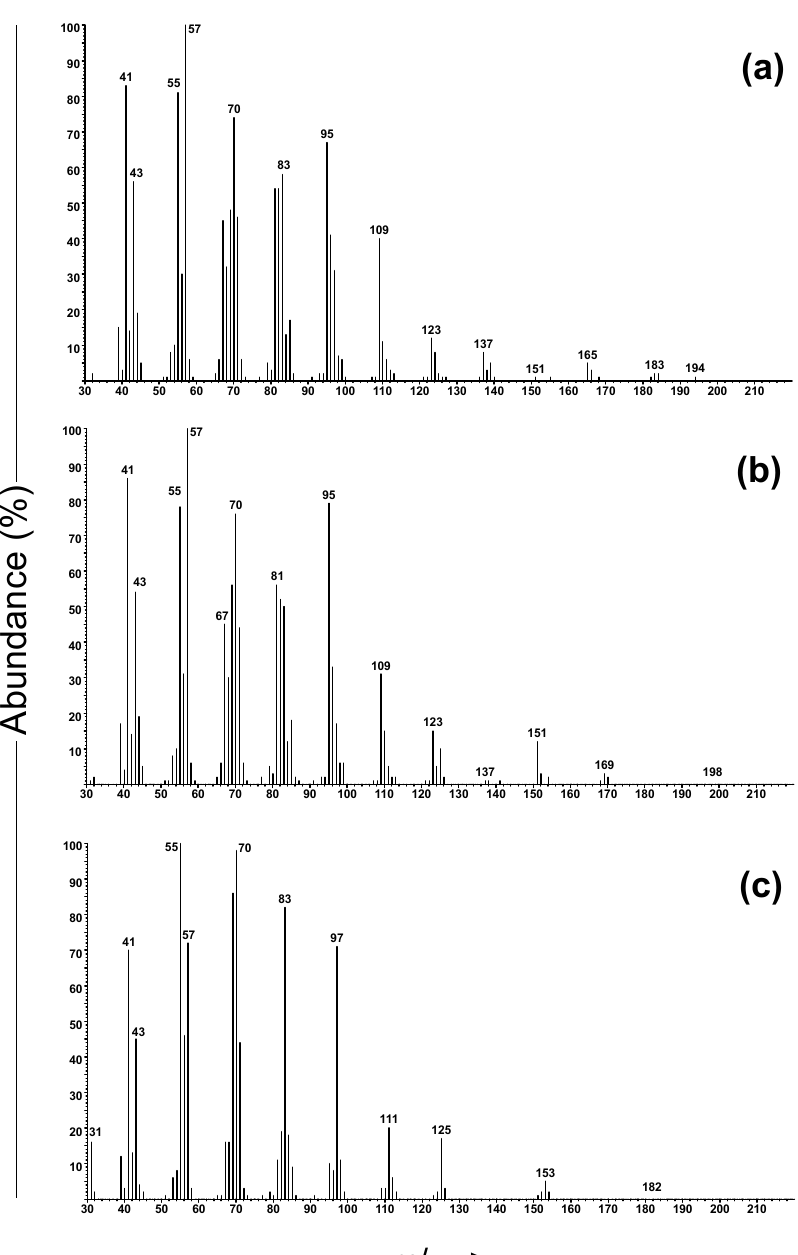
Figure 3. EI mass spectra of (a) 11-methyltridecanal, (b) 10-methyldodecanal, and (c) 10- Figure3. EImassspectraof( a )11-methyltridecanal, ( b )10-methyldodecanal, and( c methyldodecanol.